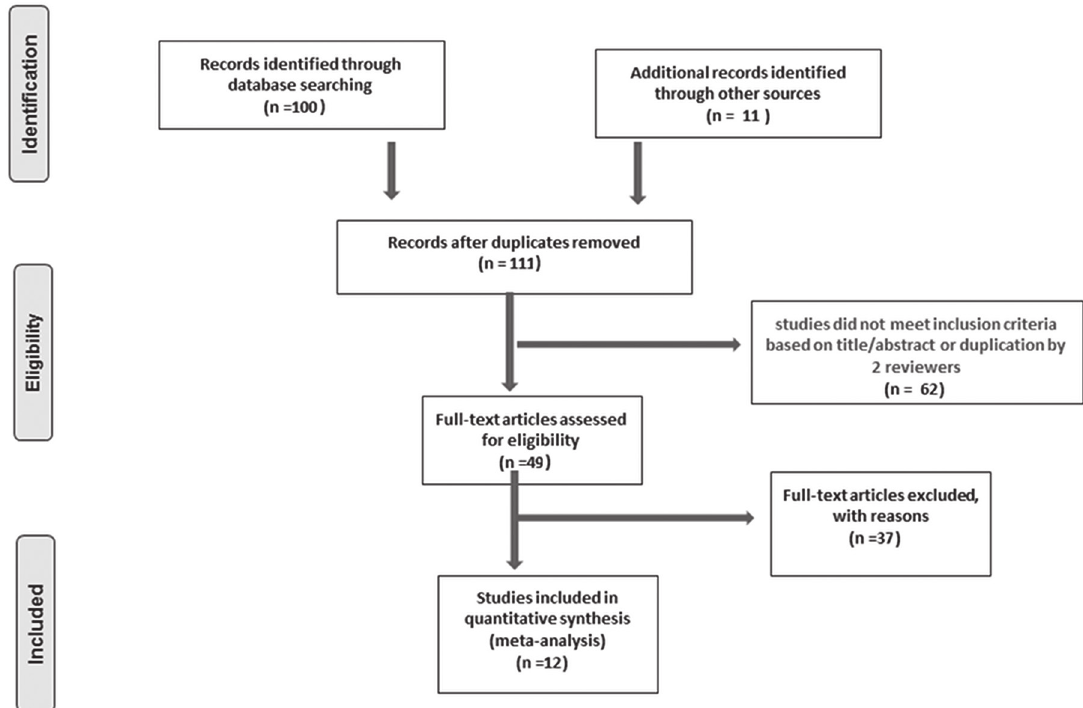
Figure 1 - Flow diagram of the study selection process (based on PRISMA